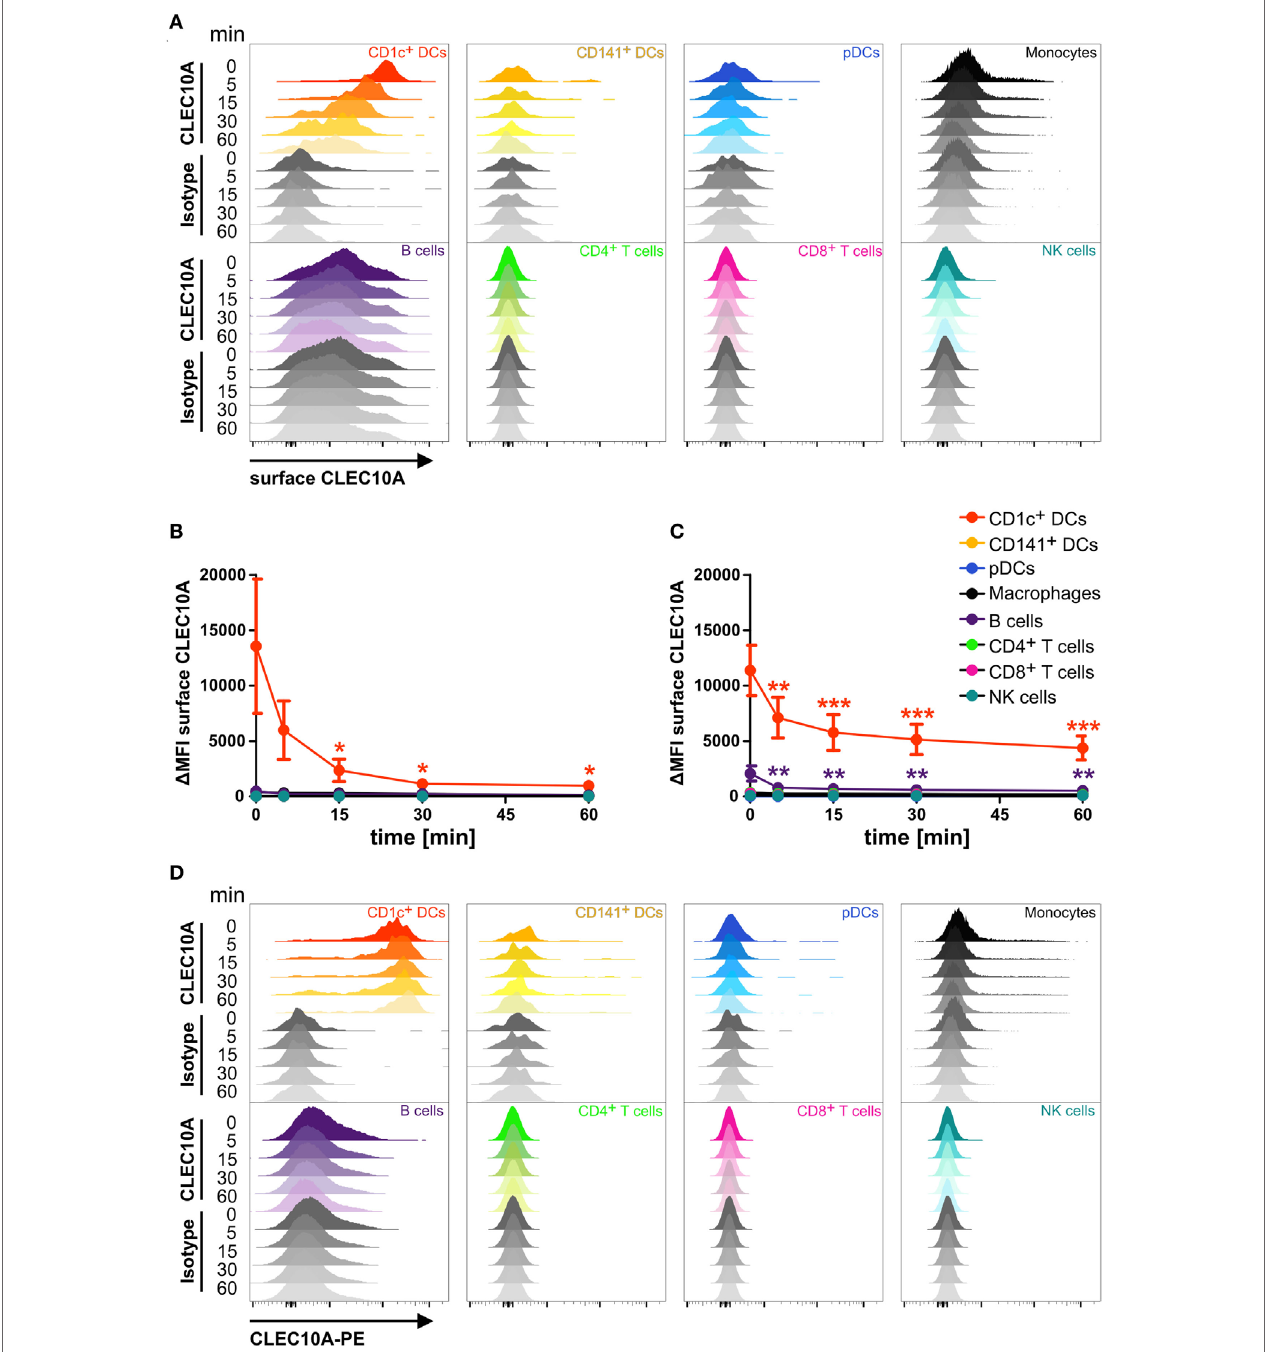
FigUre 3 | CLEC10A is rapidly internalized into blood and thymic CD1c + dendritic cells (DCs). Single cell suspensions of blood (a,B,D) and thymus (c) were incubated with a PE-coupled anti-CLEC10A antibody or an appropriate isotype control at 4°C for 15 min, washed, and resuspended in PBS containing 2% human sera. Subsequently, the cells were incubated at 37°C for different time points (0, 5, 15, 30, and 60 min) to allow for the internalization of the primary PE-coupled antibody. Afterward, the cells were stained for surface CLEC10A by an anti-PE secondary antibody (polyclonal goat IgG) and an A647-labeled tertiary anti-goat antibody. Then, the cells were stained for different immune cell populations. 2.5 × 10 6 cells were acquired using a BD LSRFortessa and analyzed using FlowJo. (a) Overlay histograms show surface expression of CLEC10A for CD1c + DCs (red), CD141 + DCs (yellow-orange), plasmacytoid DCs (pDCs) (blue), monocytes (black), B cells (purple), CD4 + T cells (green), CD8 + T cells (pink), and NK cells (cyan). (B,c) PBMCs (B) and thymic (c) cells were analyzed as in (a) . Plot shows mean ± SD of surface CLEC10A (MFI CLEC10A − MFI isotype control ) of three (c) or five (B) donors. Statistical analysis was performed using one-way ANOVA with Dunnett posttest for each cell population ( Δ MFI 0 min as control; * p < 0.05, ** p < 0.01, and *** p < 0.001). (D) Overlay histograms show the PE-signal of the primary PE-coupled anti-CLEC10A antibody or the appropriate isotype control for the same donor as in (a)